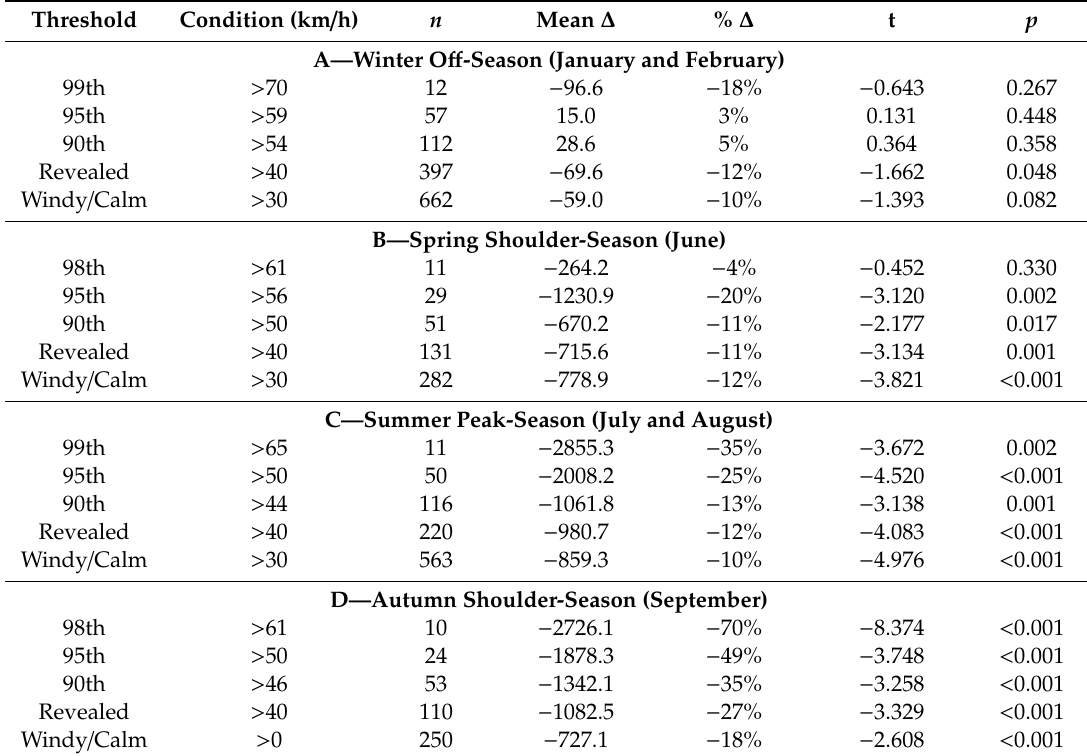
Table 5. The e ff ect of an extreme wind speed on zoo attendance in Toronto, across four di ff erent seasons.